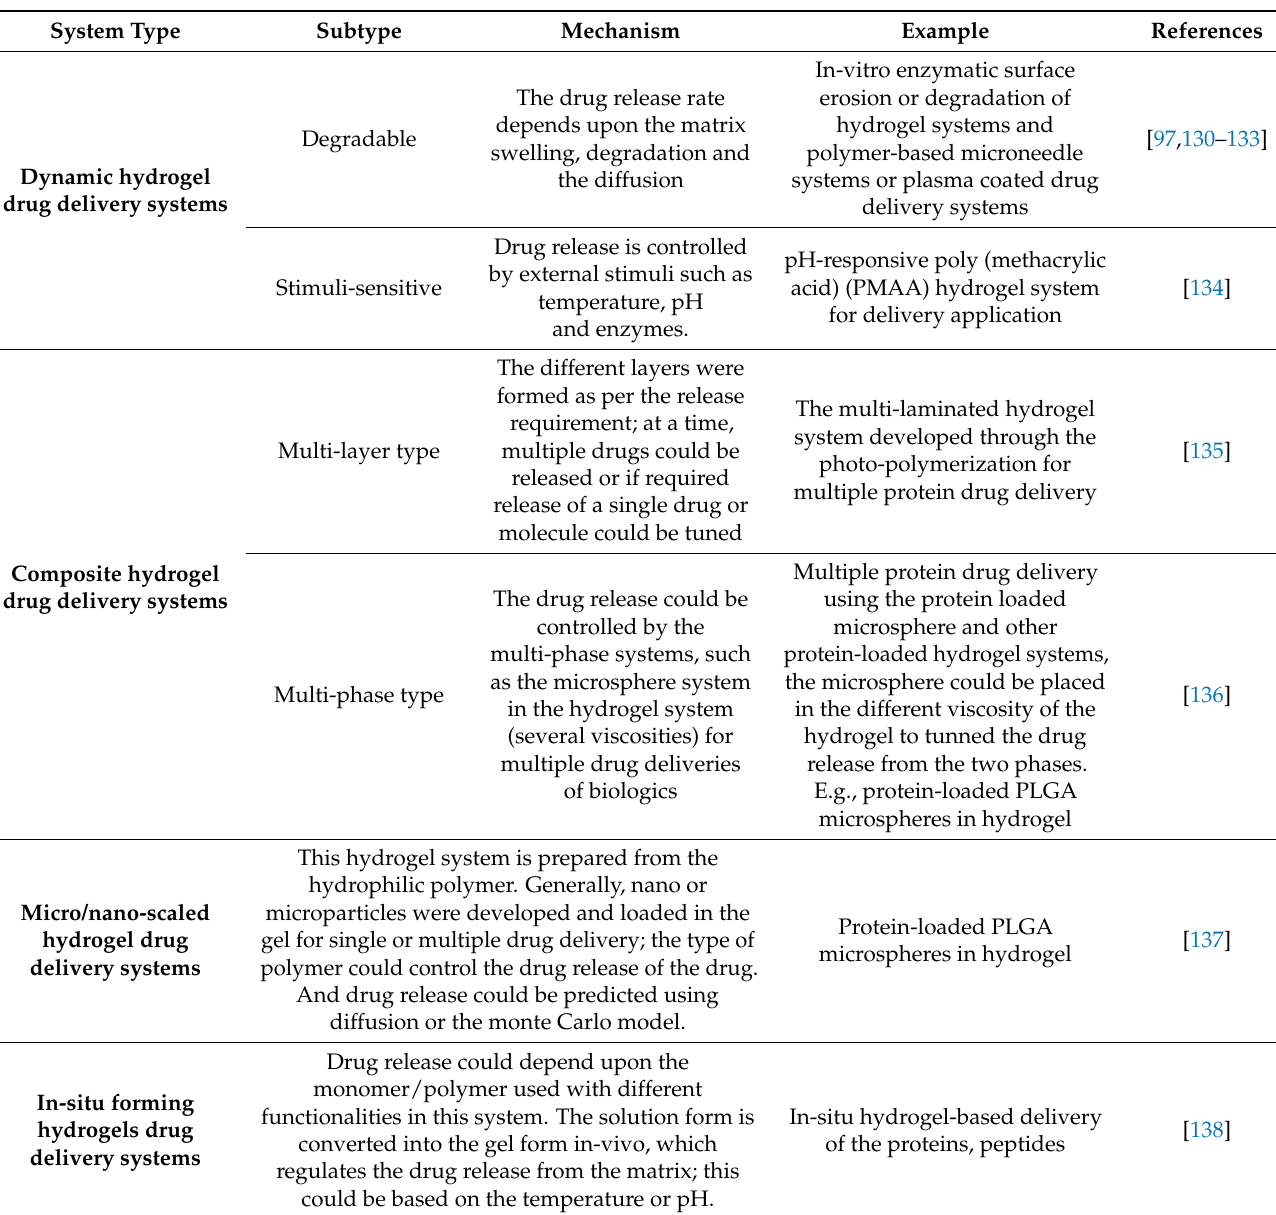
Table 3. Miscellaneous types of hydrogel systems and their drug release